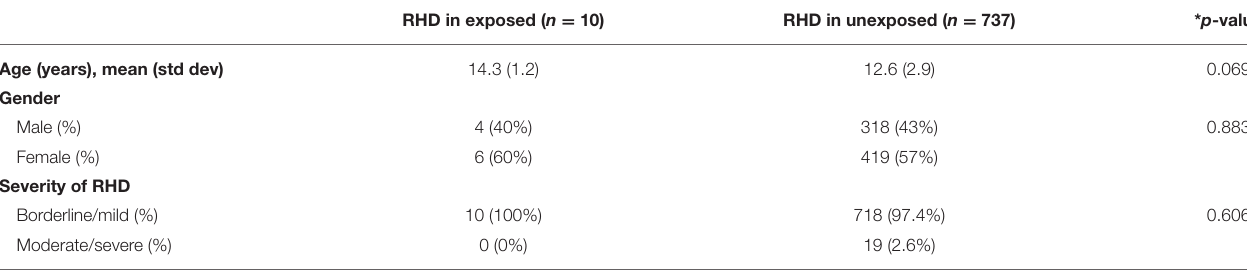
TABLE 2 | Demographic data of children with new RHD, exposed and